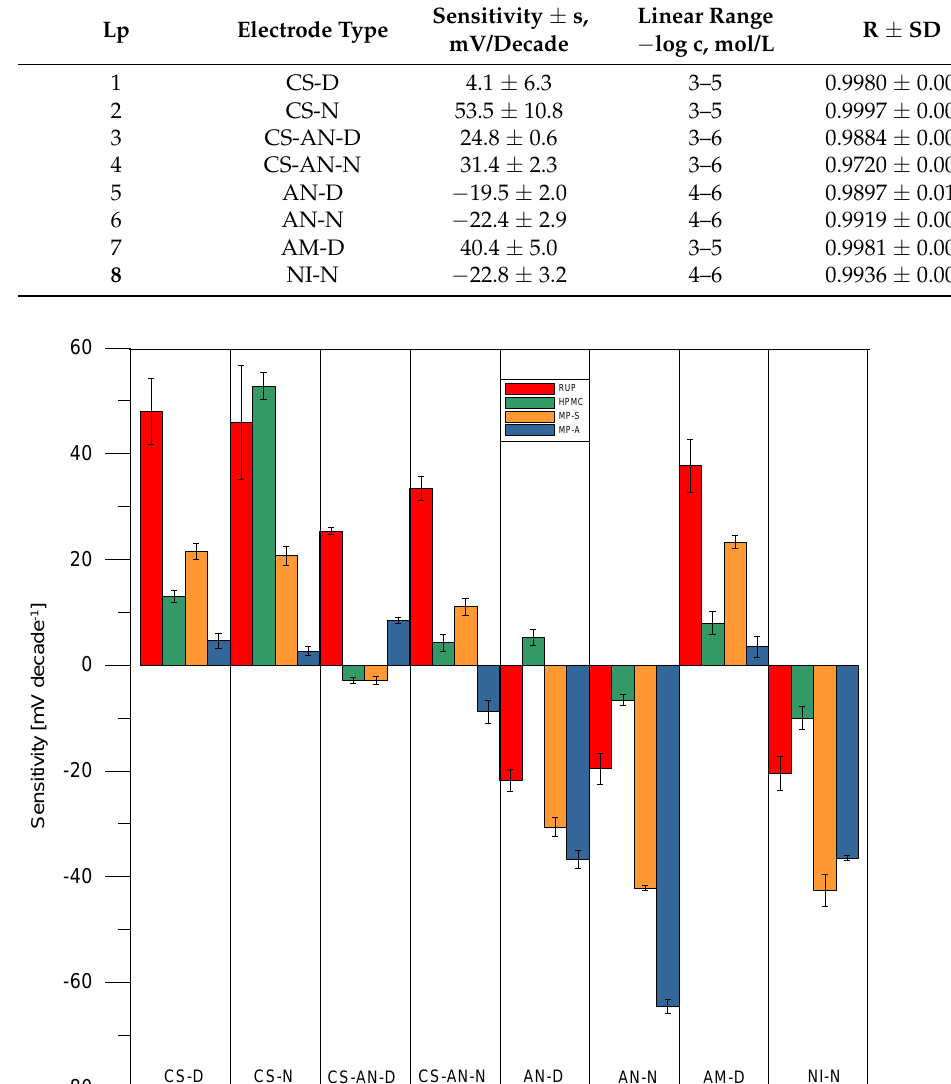
Figure 3. Sensitivity of electrodes towards RUP, HPMC, MP-S, MP-A.